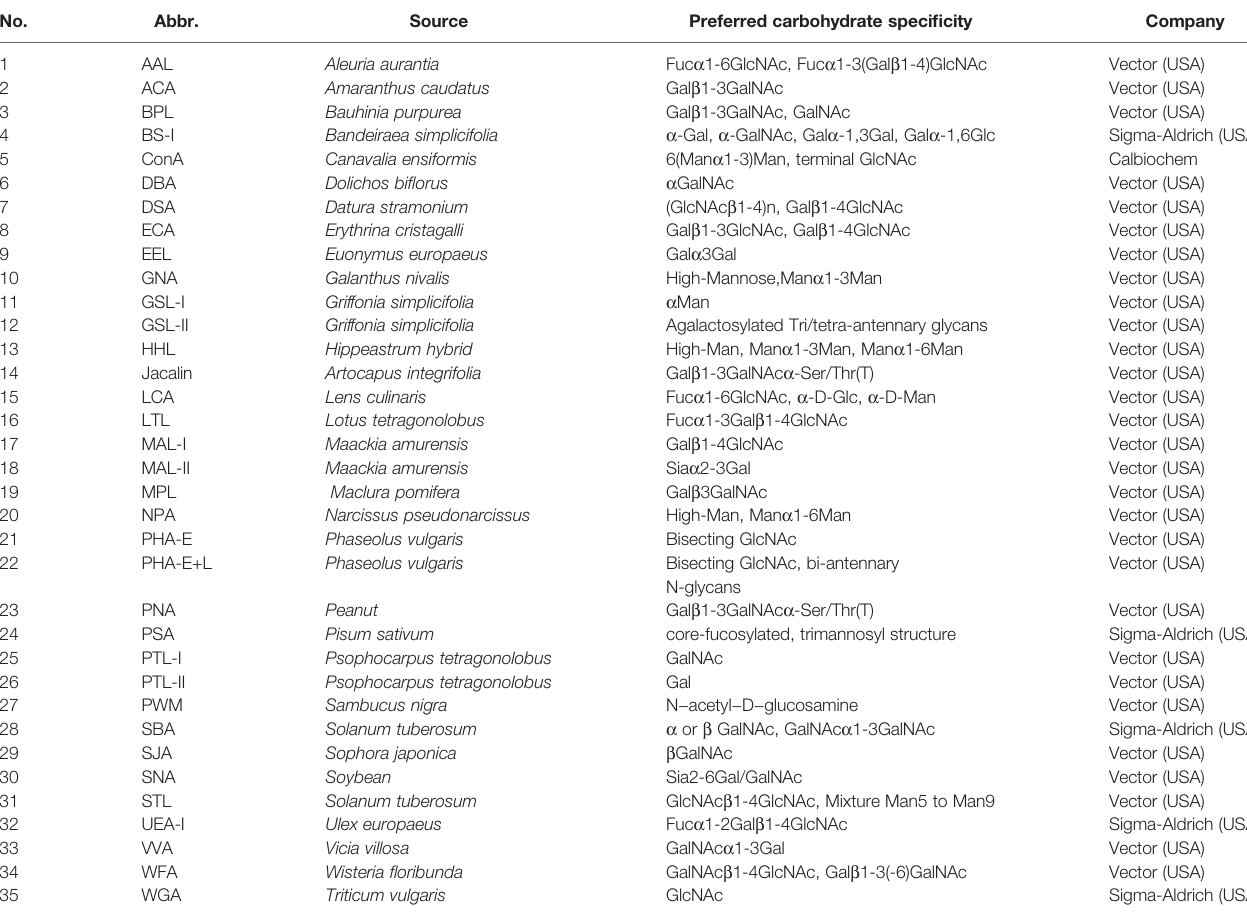
TABLE 2 | Different glycan patterns between HCC tissues and adjacent non-tumor tissues by lectin microarray analysis.